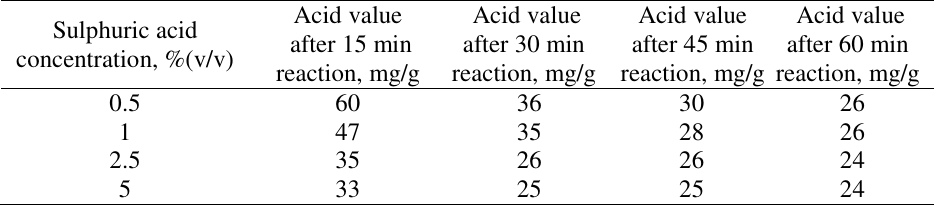
Table 2. The effect of acid catalyst (sulphuric acid) concentration on the esterification